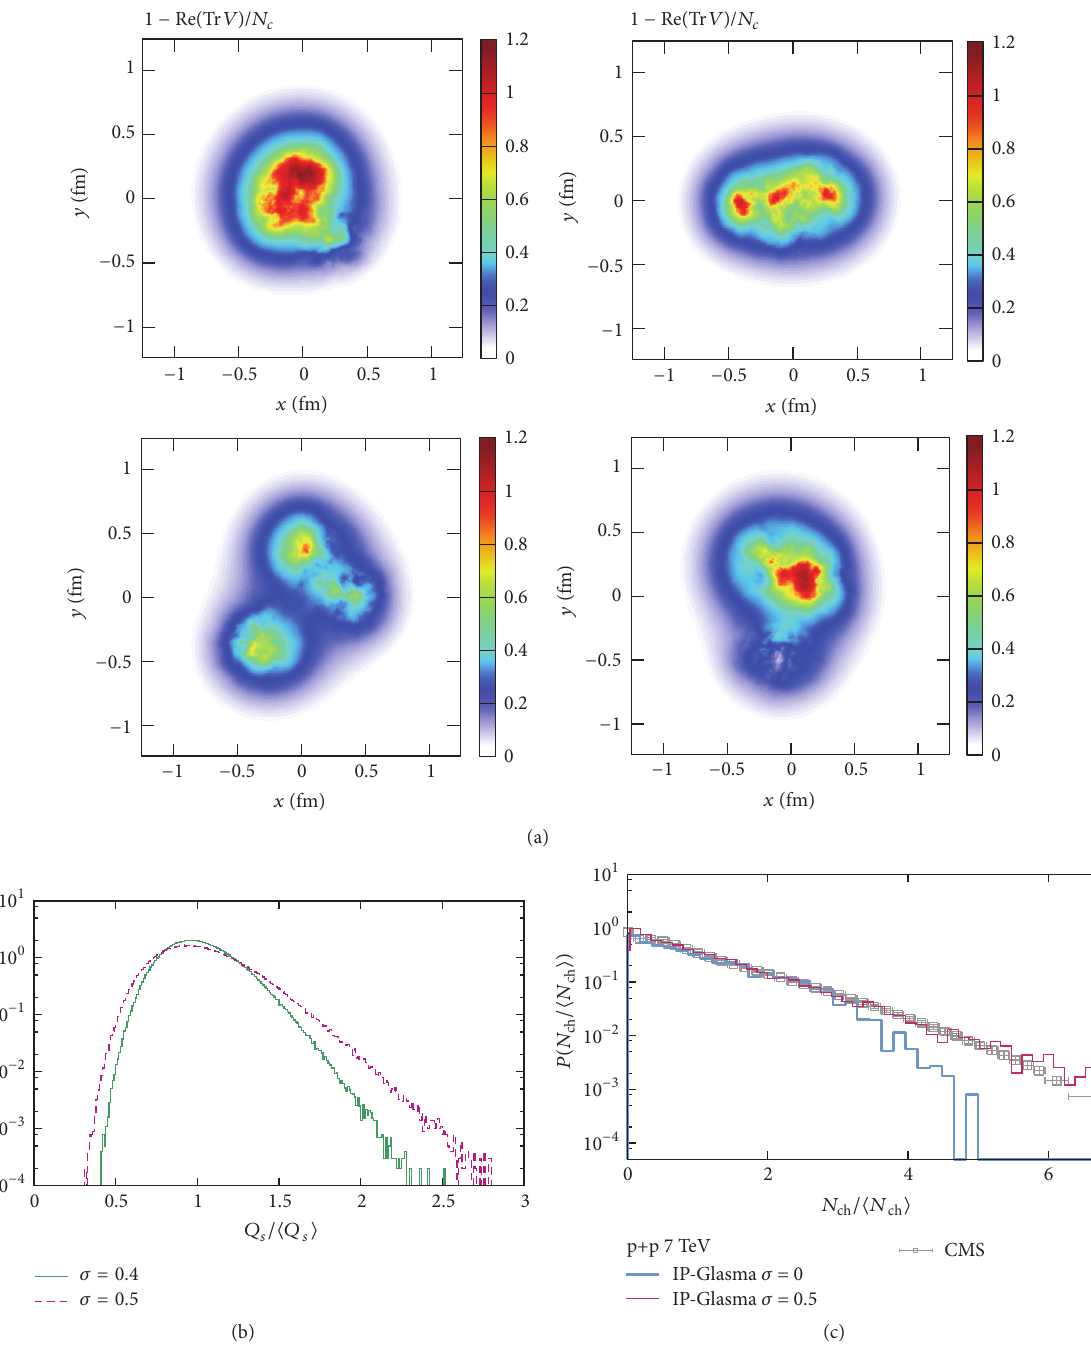
Figure 3: (a) Distribution of gluon density around valance quarks inside a proton represented by the real part of Wilson lines from [60]. (b) Distribution of the saturation scale of a proton driven by stochastic dipole splitting. (c) Effect of intrinsic fluctuation of proton saturation scale on the probability distribution of multiplicity ( 𝜎 = 0 corresponds to no fluctuation of 𝑄 𝑠 ). Figures (b) and (c) are from